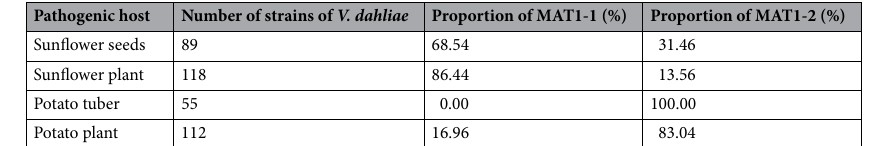
Table 3. Identification of mating type ratio of Verticillium dahliae.